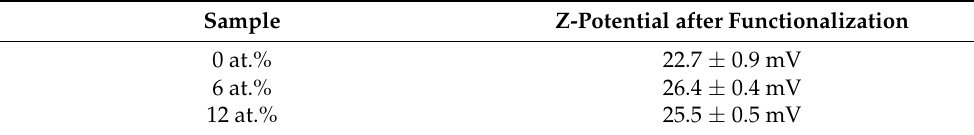
Table 6. Z-potential of Fe:ZnO NPs with amino functionalization. The Z-potentials are expressed as mean values ± standard deviation of three measurements.